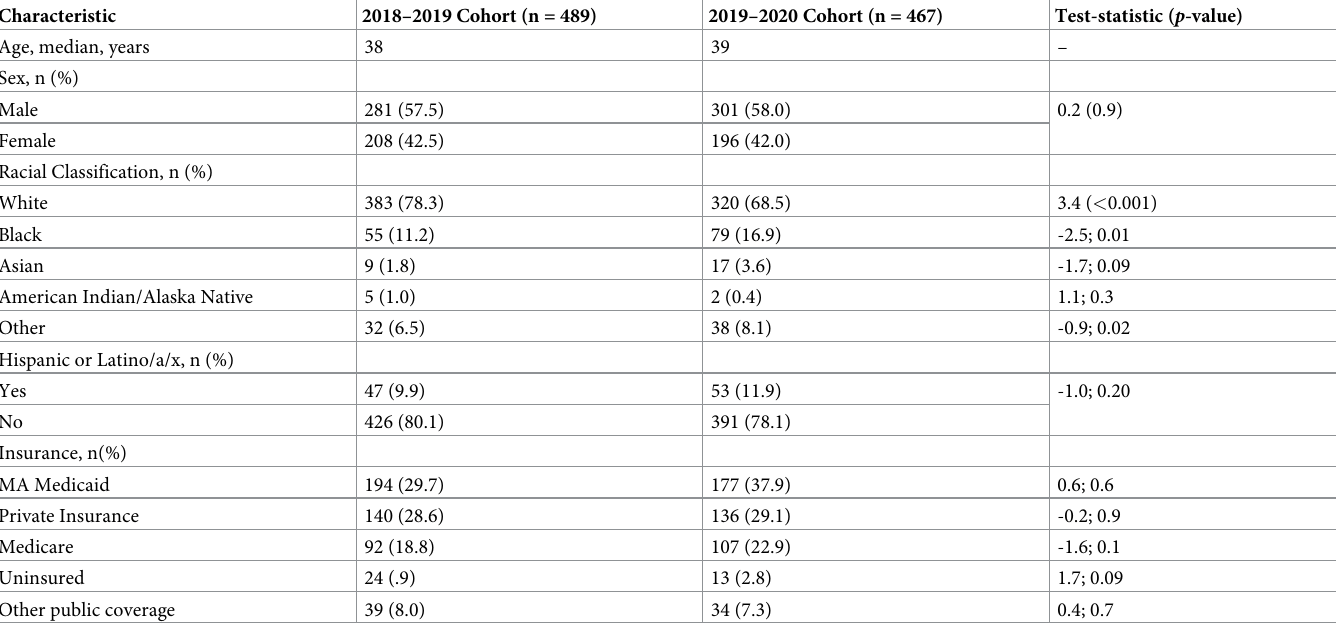
Table 1. Pre-period unadjusted comparison of demographic characteristics.